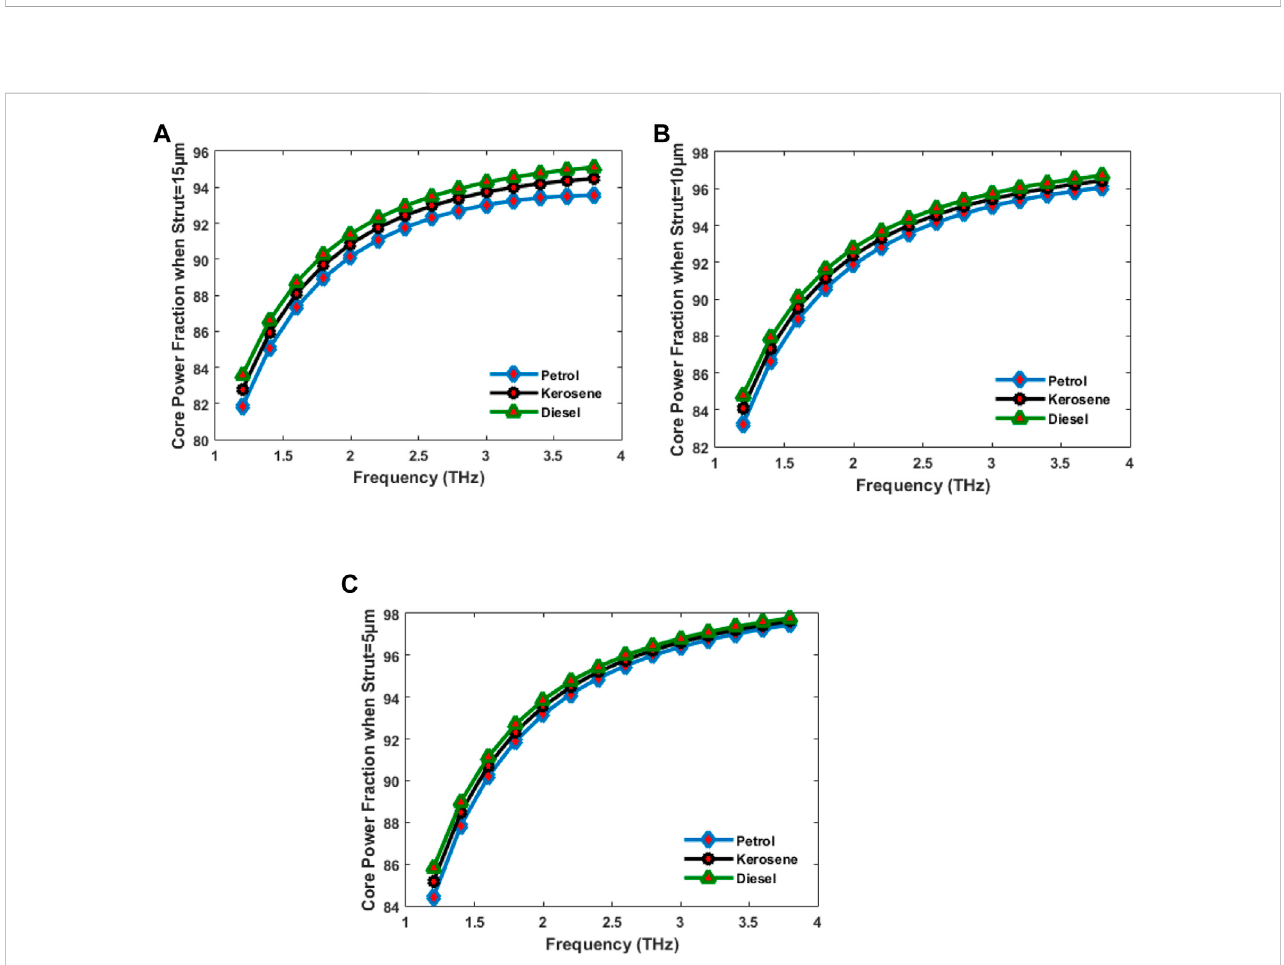
Core power fraction for different petrochemicals. (A) Strut distance 15 μ m. (B) Strut distance 10 μ m. (C) Strut distance 5 μ